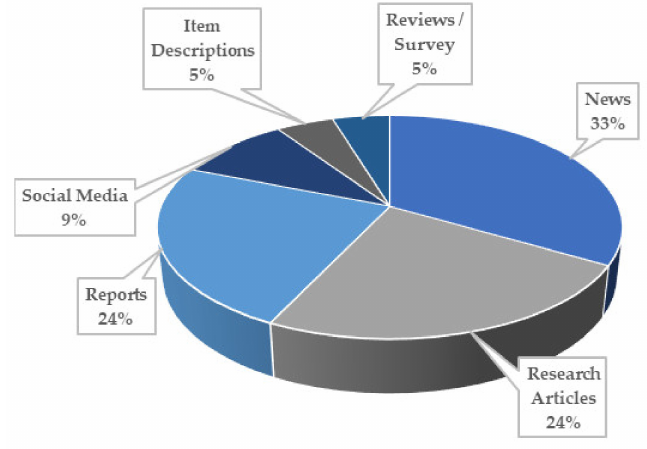
Figure 5. Distribution of data sources used in the articles listed in Table 2, selected via the search criteria related to Text Mining in Supply Chain Risk Management.